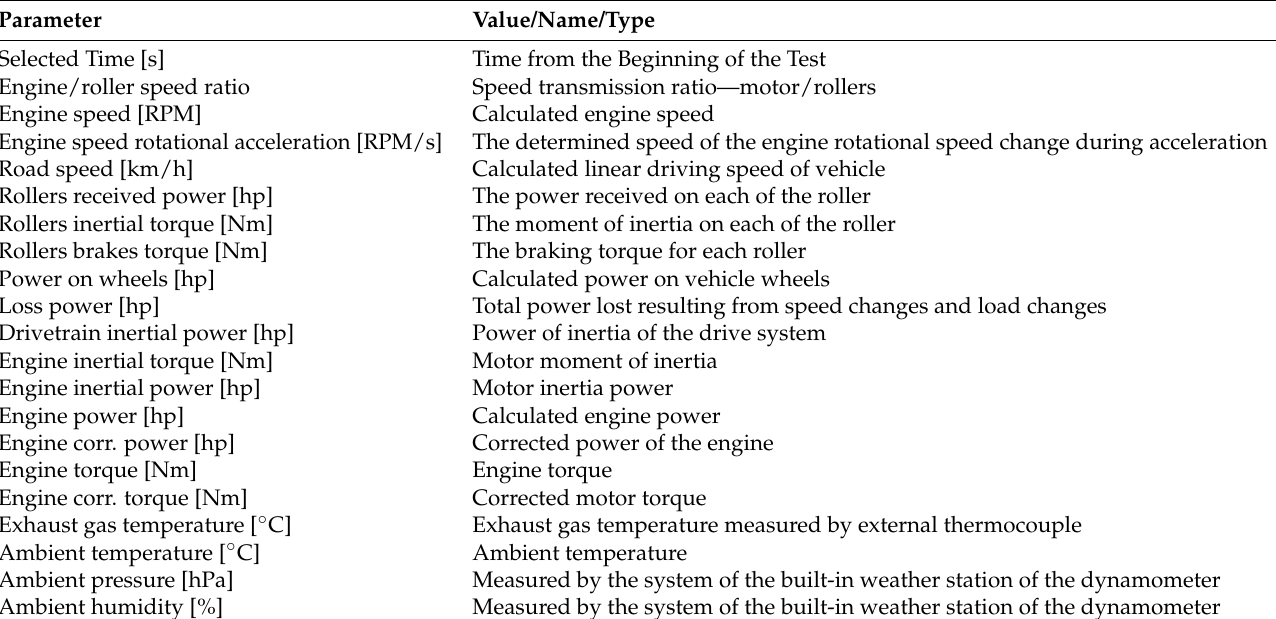
Table 4. Selected parameters characterizing the chassis dynamometer measured with the use of the dynamometer controller (manufacturer’s